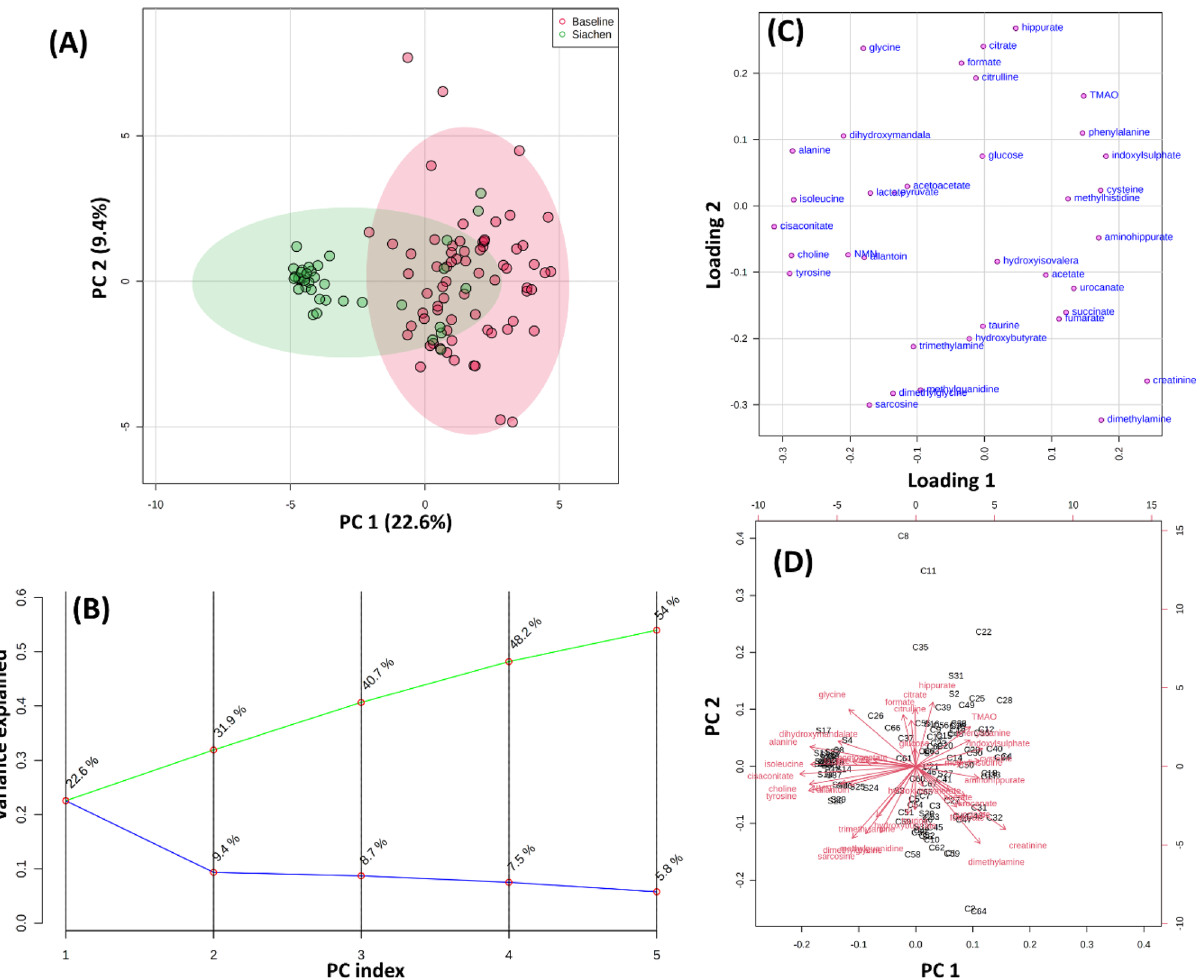
Figure 4. ( A ) PCA score plot between component 1 versus component 2 for 1H-NMR urine spectra from sea level Baseline group and Siachen group. ( B ) Scree plot was generated for the first five Principal components (PCs) to identify the contribution of each of the principal components to the total variation in the data set. The green line showed the cumulative variance explained by the first five components which accounted for 54% whereas blue line indicated the individual variance for each principal component. ( C ) Loading plots from PCA indicating the metabolites that lied far away from the origin and were responsible for separating the two groups. ( D ) PCA biplot between the selected PCs. Biplot for baseline and Siachen group identifying the relationship between samples and metabolites where samples were displayed as points and metabolites were displayed as